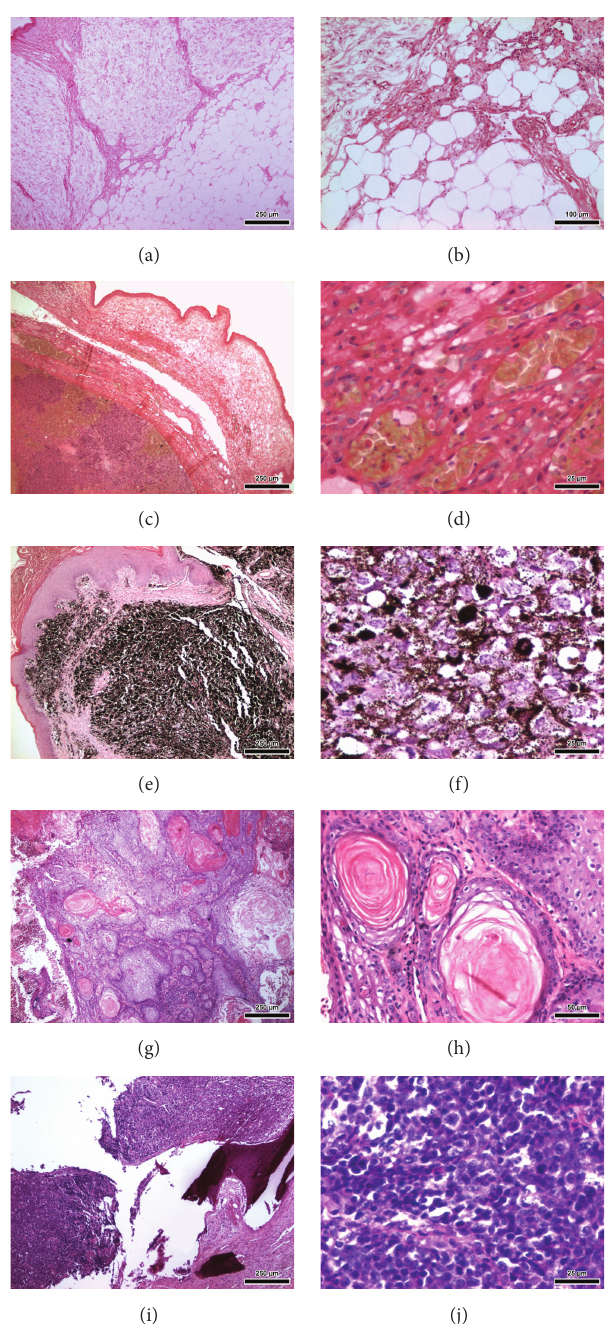
Figure 1: Histological photomicrographs of avian neoplasms—Hematoxylin and Eosin stain (H&E). (a) and (b) Case number 1: pericloacal lipoma ( A. aestiva ). (c) and (d) Case number 2: well-differentiated hemangiosarcoma in pelvic limb ( A. aestiva ). (e) and (f) Case number 3: mandibular melanoma ( Ara ararauna ). (g) and (h) Case number 11: oral squamous cell carcinoma ( Diopsittaca nobilis ). (i) and (j) Case number 15: distal tibiotarsal lymphoma ( Amazona